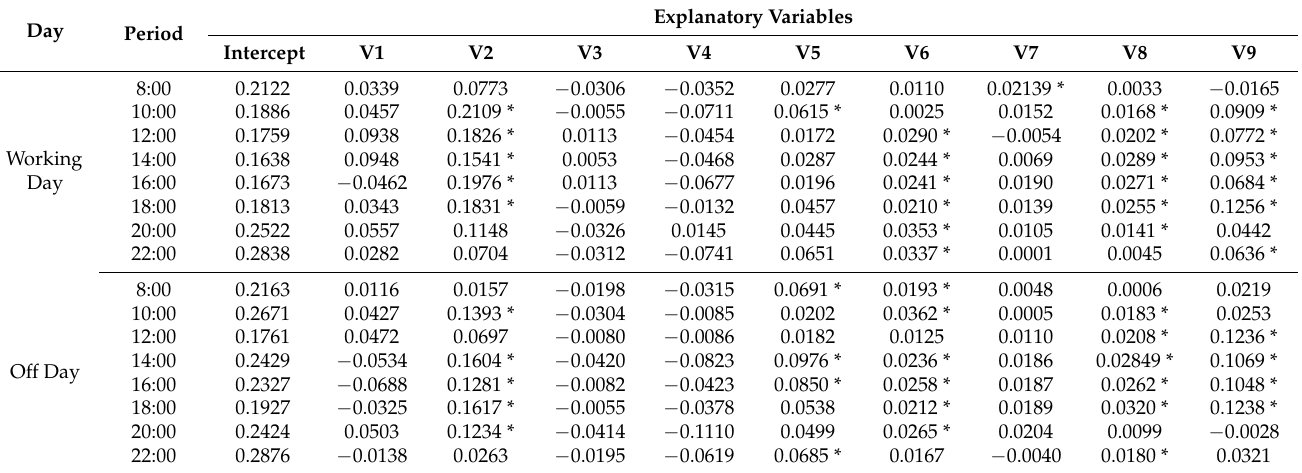
Table 7. The OLS regression results for the LSY station